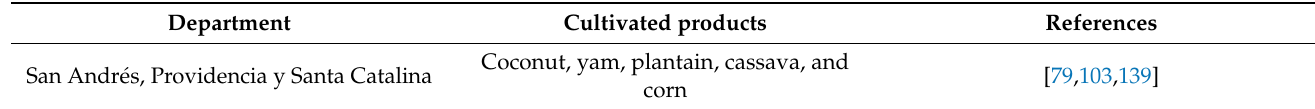
Table 12. Insular